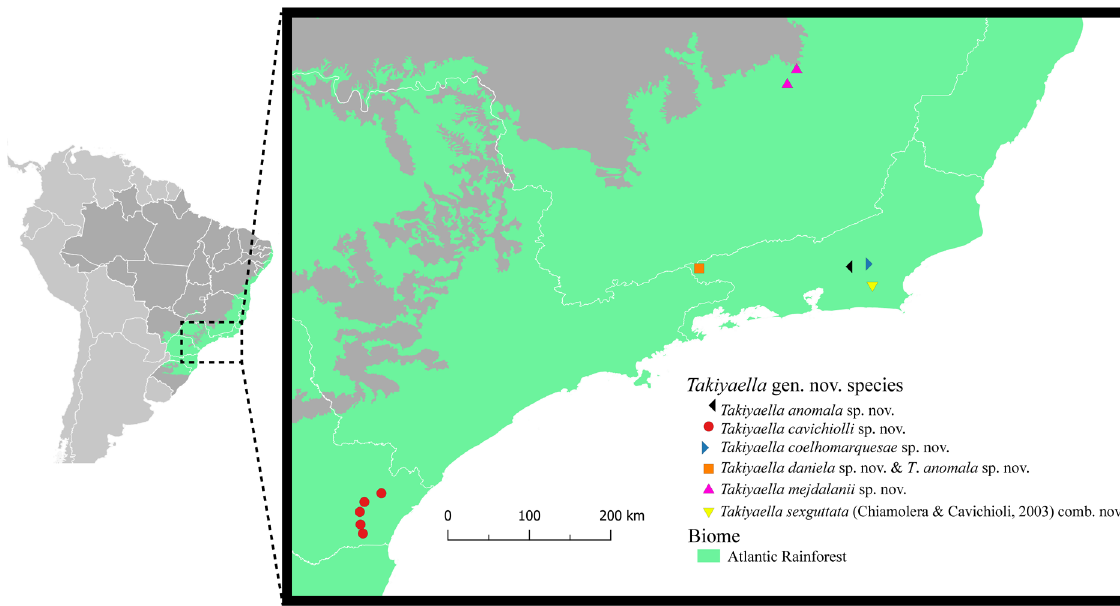
Fig. 13. Distribution map of all known species of Takiyaella gen.